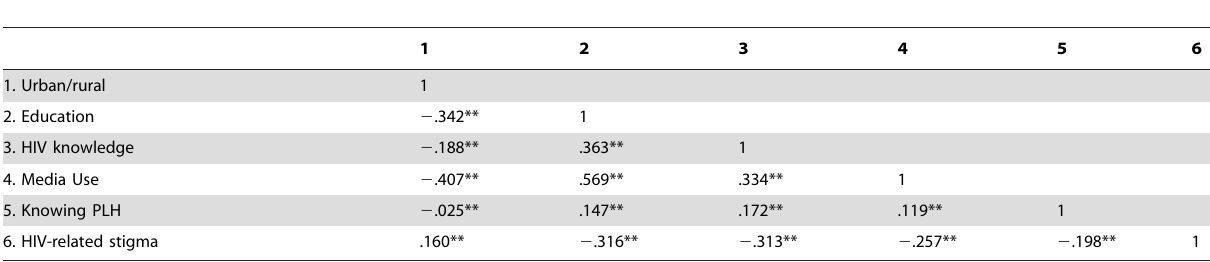
Table 2. Zero-order bivariate correlations between the independent and dependent variables.